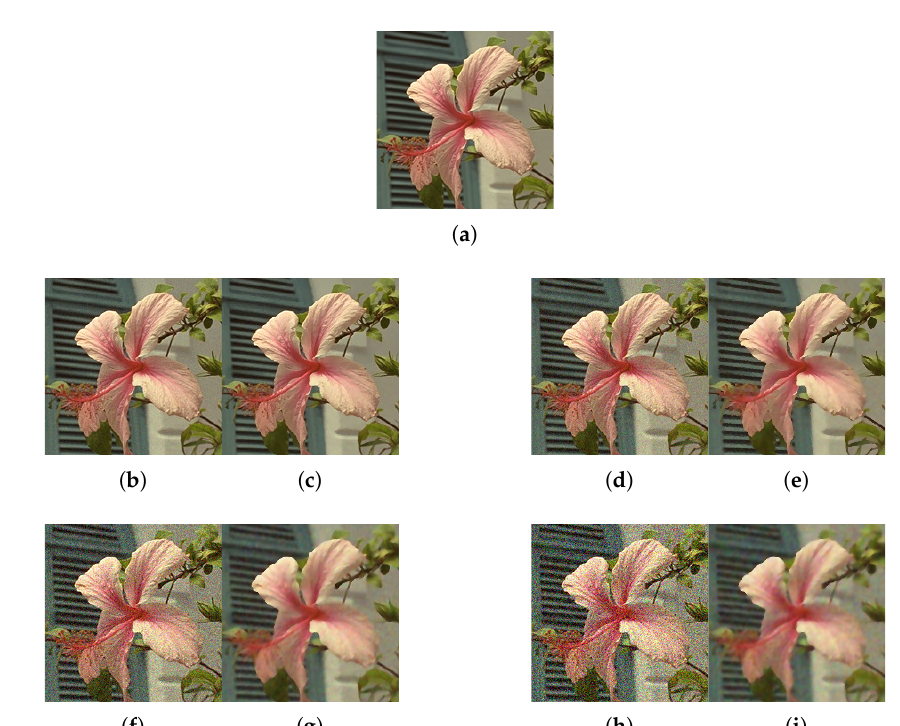
Figure 11. Method outputs using test image Flower contaminated with various intensities of Gaussian σ . ( a ) Flower. ( b ) Noisy σ = 5. ( c ) Filter output. ( d ) Noisy σ = 10. ( e ) Filter output. ( f ) Noisy σ = 20. ( g ) Filter output. ( h ) Noisy σ = 30. ( i ) Filter output.